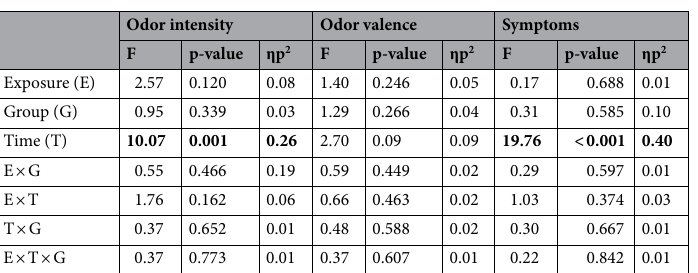
Table 2. Results from the three-way ANOVAs for odor intensity, valence, and symptoms (F-values and, if statistically significant, ηp 2 values within brackets) with two groups (Referents/BRS). Significant values are in